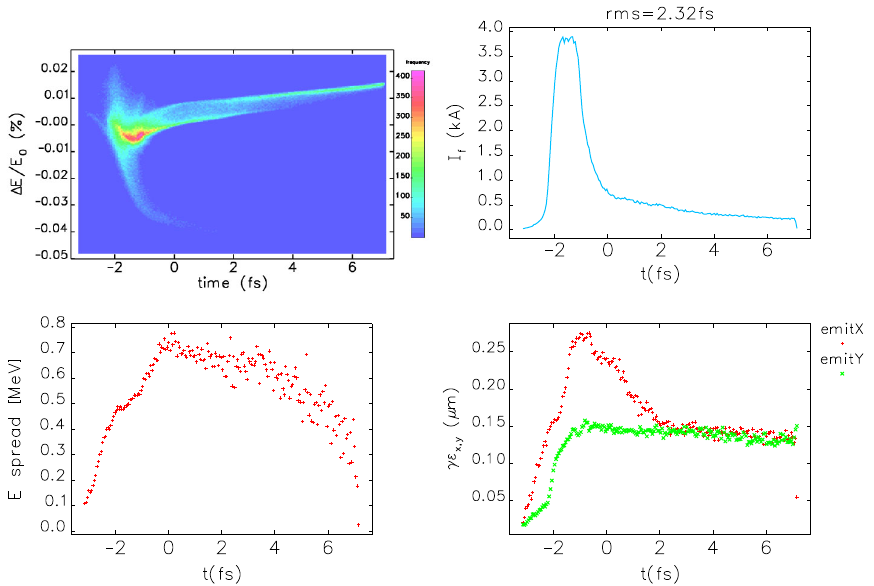
FIG. 7. Electron beam properties at the end of Linac3. Left top: longitudinal phase space; left bottom: longitudinally sliced energy spread; right top: current profile; right bottom: longitudinally sliced emittance. A normalized transverse emittance of 0 : 14 (cid:1) m is preserved at the core part of the electron bunch, with a pulse duration length of 2 fs. A peak current of 4 kA and a longitudinally sliced relative energy spread less than 1 (cid:1) 10 (cid:2) 4 is achieved. The residual correlated energy offset established in Linac1 and Linac2 is removed in Linac3 with the help of strong X -band rf longitudinal wakefield, and a flat final energy profile is achieved at a beam energy of 6